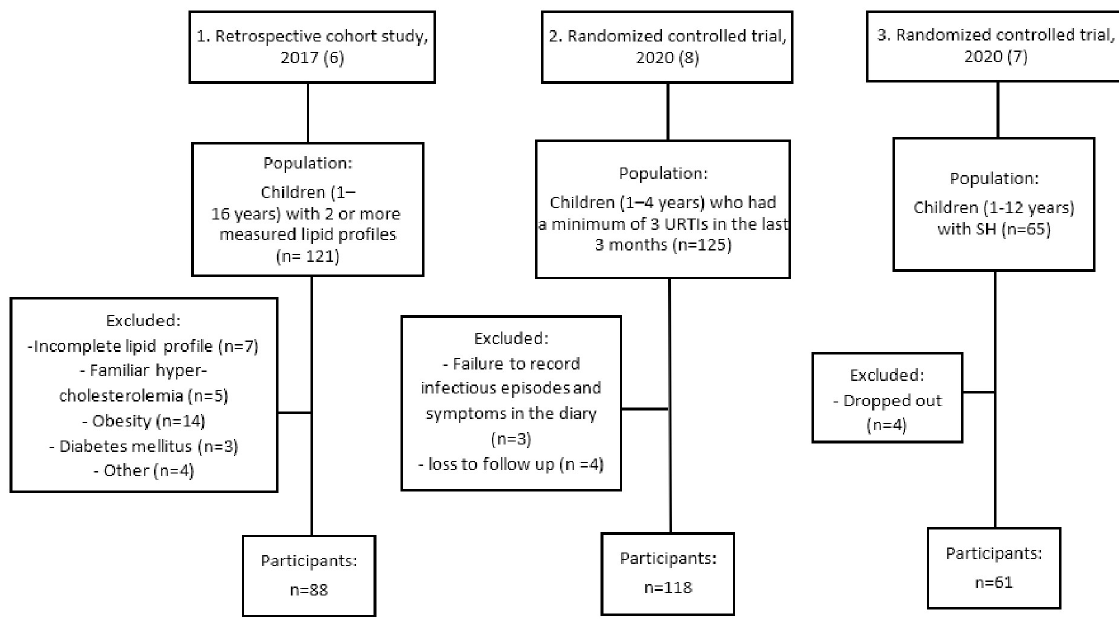
Fig 1. Schematic overview of the data collection of three previous conducted studies used for this pooled analysis. One retrospective cohort study and two RCTs.